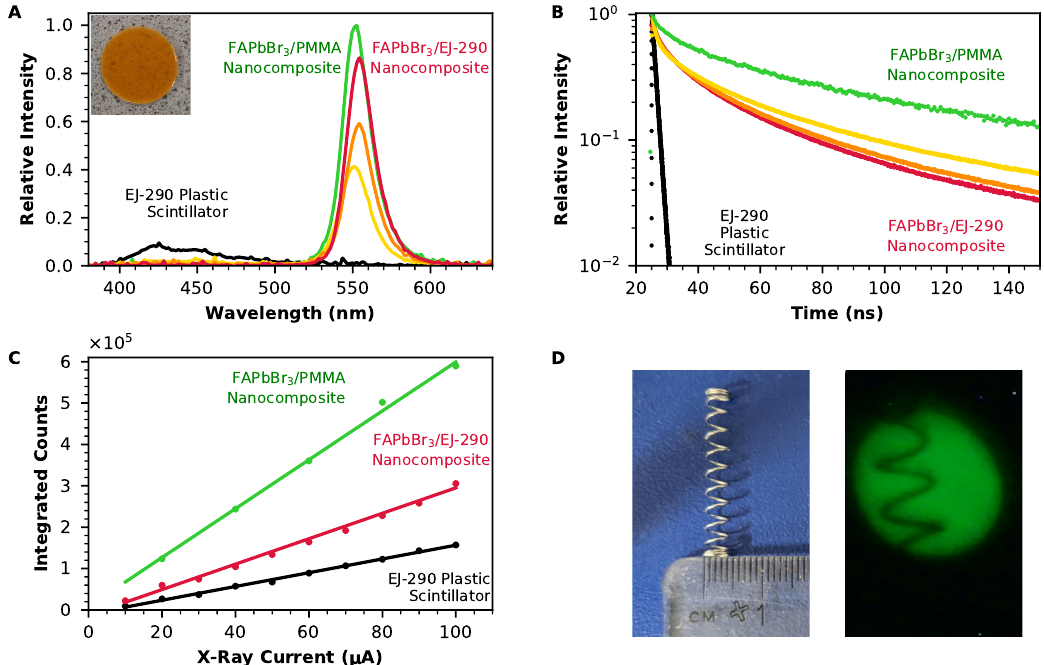
Figure 3. ( A ) Radioluminescence spectra for the FAPbBr 3 /PMMA nanocomposite with 1.8 wt% loading of FAPbBr 3 nanocrystals (green), FAPbBr 3 /EJ-290 nanocomposite scintillators with 0.4 wt% (yellow), 0.9 wt% (orange), and 1.8 wt% (red) loading of FAPbBr 3 nanocrystals and for a 1 mm-thick disc of EJ-290 plastic scintillator (black). ( B ) Photoluminescence decays for the 1.8 wt% loading FAPbBr 3 /PMMA nanocomposite (green), FAPbBr 3 /EJ-290 nanocomposite scintillators of various loadings (0.4%/0.9%/1.8%, yellow/orange/red), and the EJ-290 plastic scintillator (black). ( C ) Ra- dioluminescence intensity as a function of the dose rate for the FAPbBr 3 /PMMA nanocomposite with 1.8 wt% loading (green), FAPbBr 3 /EJ-290 nanocomposite with 1.8 wt% loading (red), and EJ-290 plastic scintillator (black). ( D ) Photograph (left) and X-ray image (right) of metal spring, acquired using the 1.8 wt% loading FAPbBr 3 /PMMA nanocomposite scintillator. The peak emission wavelengths for the FAPbBr 3 /EJ-290 nanocomposites with 0.4%, 0.9%, and 1.8% loading occur at 551 nm, 554 nm, and 554 nm, respectively. These emission wavelengths are red-shifted from the 531 nm emission recorded for the same nanocrystals in the toluene dispersion, particularly for the two composites with a higher loading. This wavelength shift is consistent with self-absorption in the composite, which occurs due to the small Stokes shift of FAPbBr 3 . As the absorption curve of the perovskite overlaps the emission peak at higher energies, only the long-wavelength tail of the initial luminescence is transmitted through the